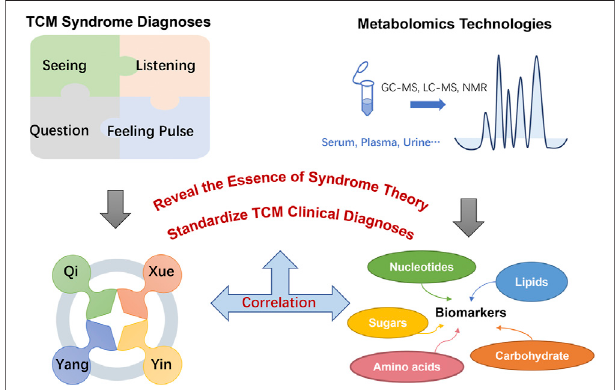
FIGURE 1 | Differentiating TCM syndromes among patients with